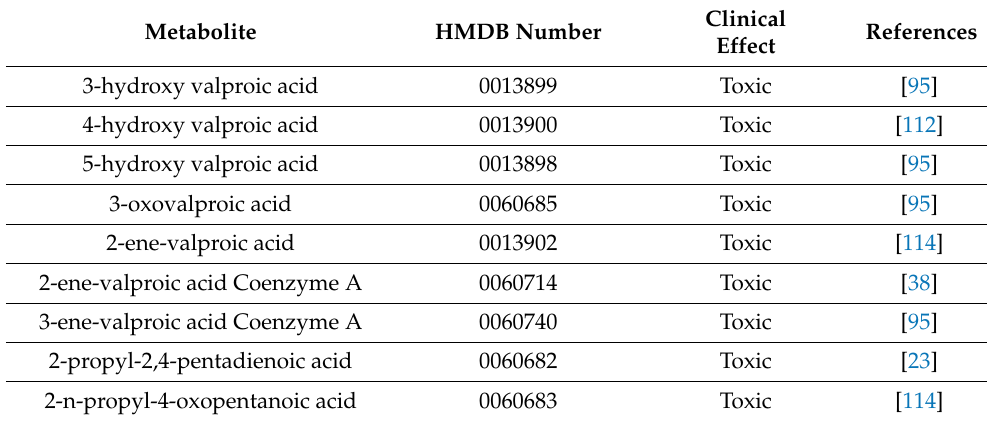
Table 4. Urinary Toxic Metabolites of Valproic